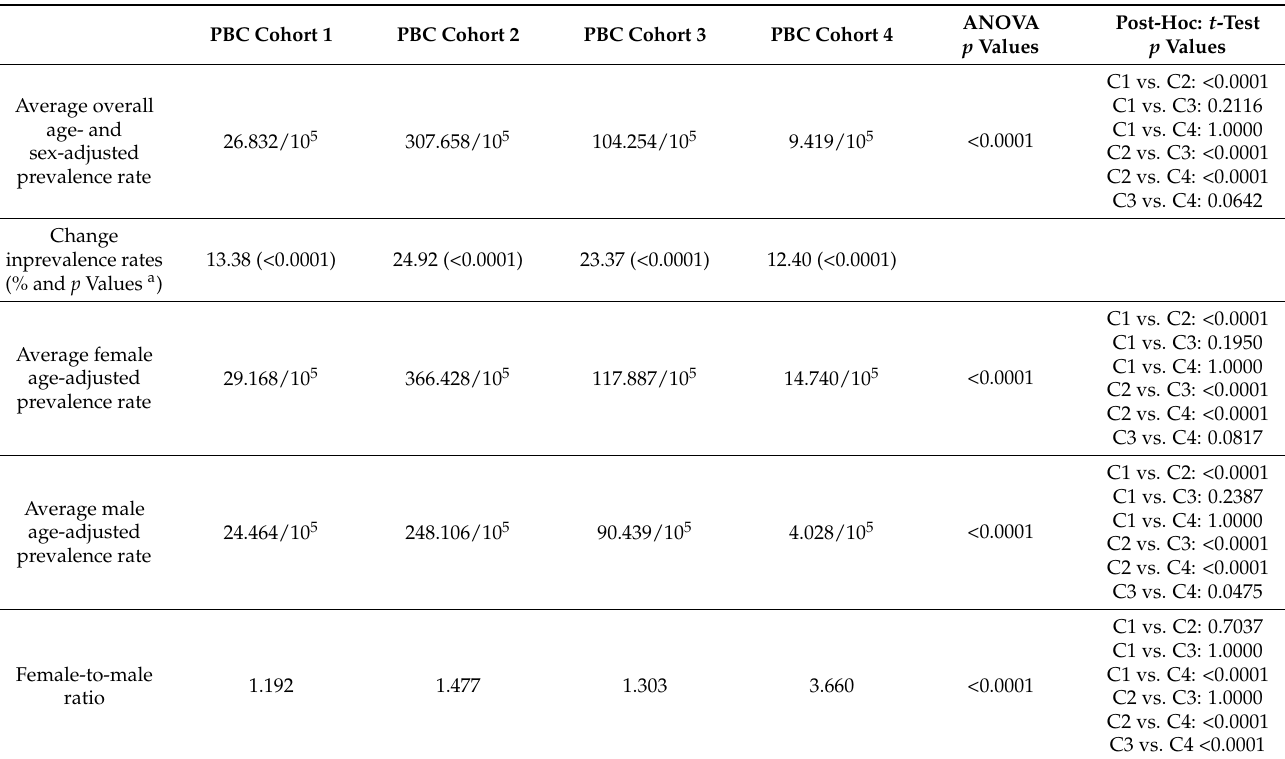
Table 2. Prevalence rates of the 4 PBC